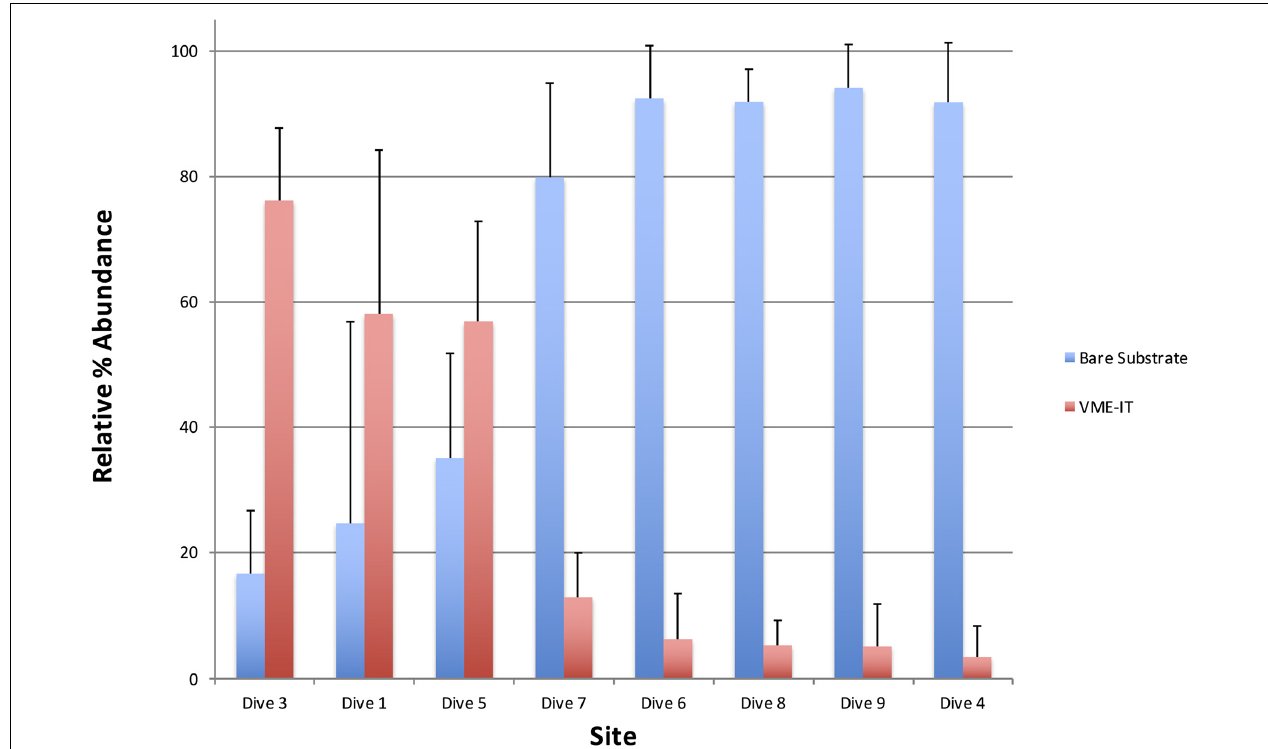
FIGURE 4 | Average relative abundances of VME indicator taxa (VME-IT) and bare substrate as measured in PAPARA(ZZ)I. Bars are standard deviation.